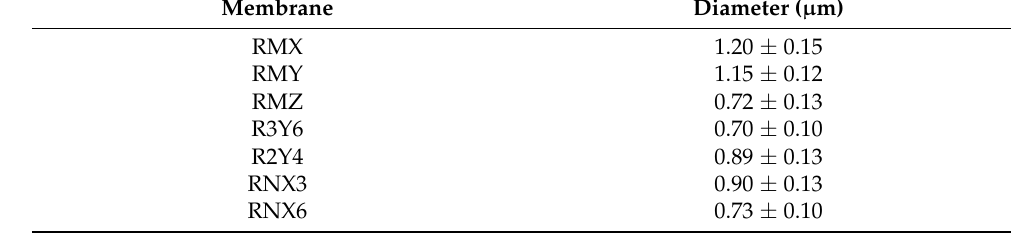
Figure 2. SEM images of membranes: ( a ) R3Y6 (6000×), ( b ) R2Y4 (6000×), and ( c ) RNX3 (8000×). The obtained SEM images allowed for the analysis of the diameter and alignment distributions of the produced membranes. This analysis was performed with the plugin OrientationJ from the software ImageJ using the obtained SEM images at 2000× magnifi- cation for the diameters (Table 2) and at 500× magnification for the alignment, which are evaluated graphically in Figure 3. Arbitrarily, the highest count of fibers was set as the 90° angle for an easier interpretation of the graph. Table 2. Fiber diameters for the different membranes, obtained through ImageJ from SEM data.